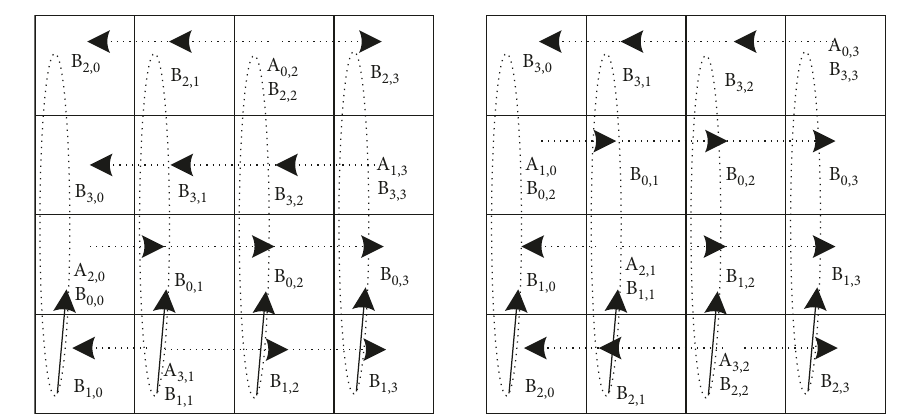
Figure 7: A 02 , A 03 Algorithm process.